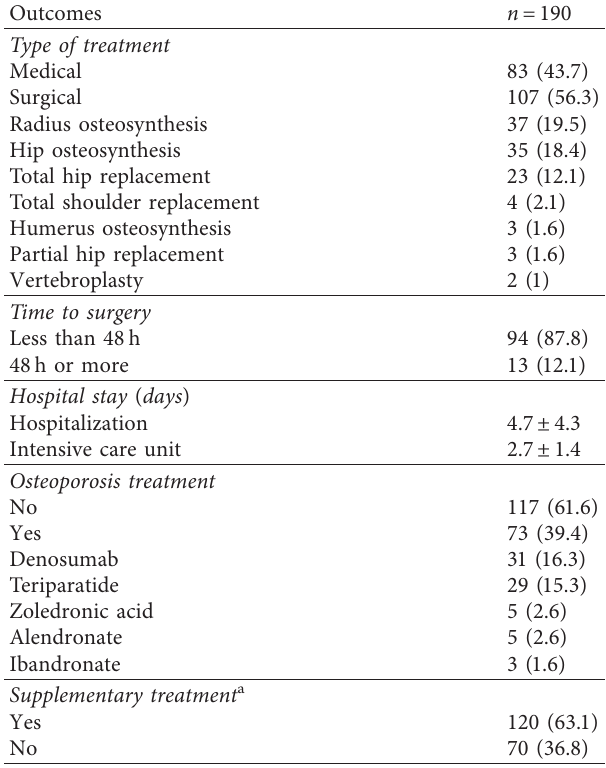
Table 3: Postfracture treatment outcomes.